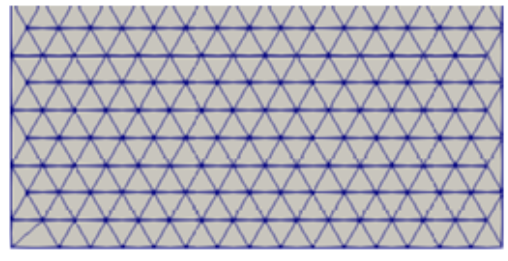
Figure 2. FISOC workflow. The black arrow indicates the direction of simulated time. The yellow arrows indicate the order of events during a FISOC simulation. The green boxes indicate when re- gridding and passing of variables between components occurs. The length of the blue boxes in the vertical indicates the relative size of time steps and coupling interval (this is illustrative; in practice there will be many more OM time steps per ISM time step and the ISM time step size will usually equal the coupling interval).